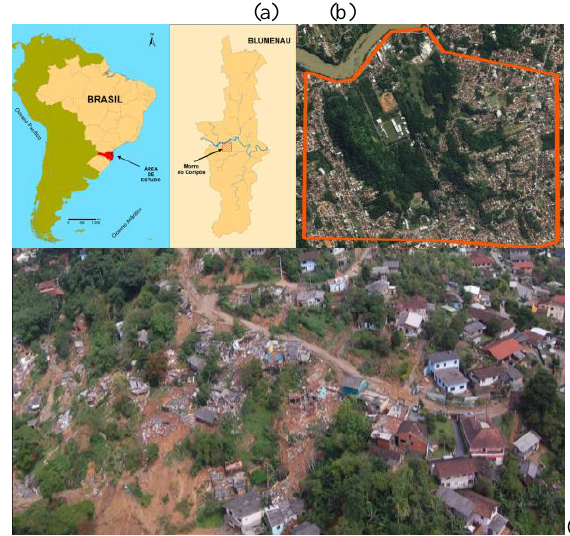
Figure 13. Study Area: (a) location Map; (b) Image adapted from Google Earth (2018); (c) Delisation occurred at 2008 (Geoprospec, 2011).